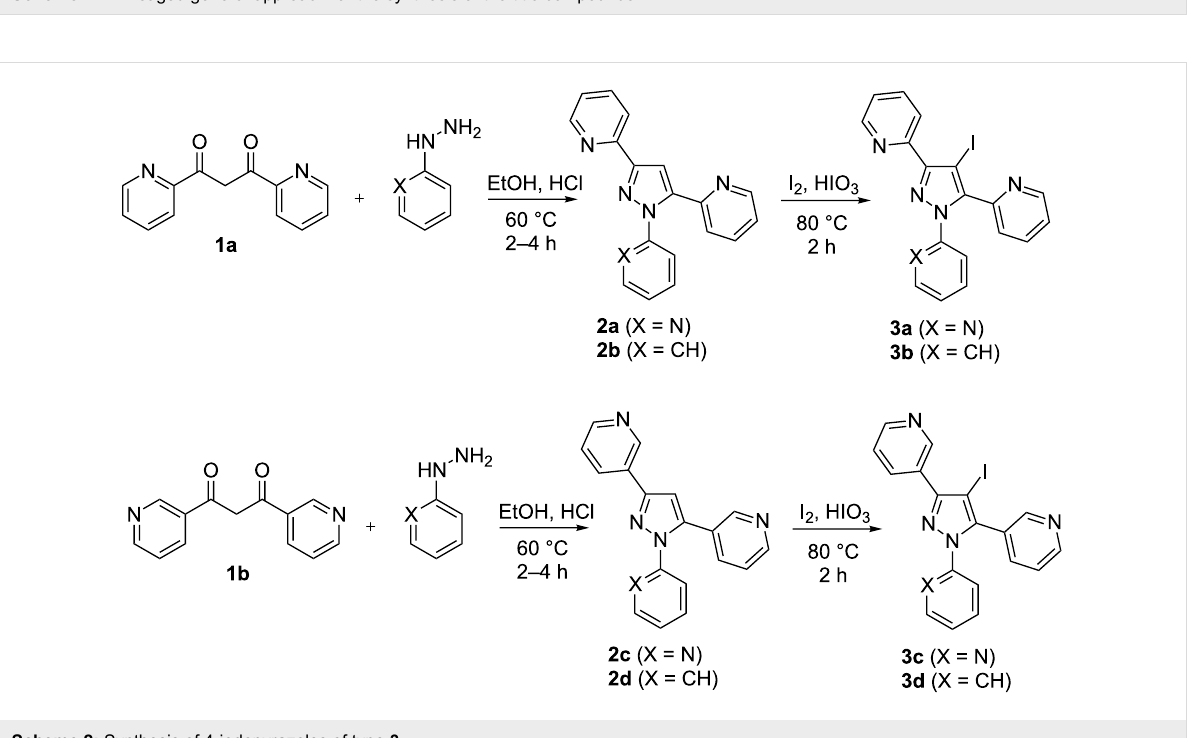
Scheme 1: Envisaged general approach for the synthesis of the title compounds.